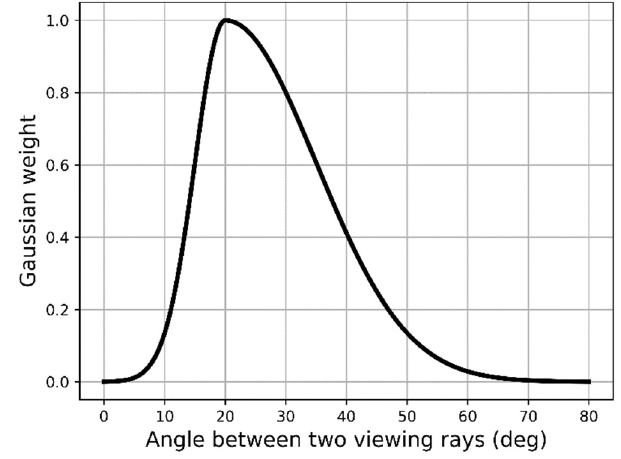
Figure 1. Gaussian weight to the angle (adopted from Furukawa et al. [34]). The final accuracy of 𝑃 is taken as the minimum value of 𝜎 (cid:3014)(cid:3023)(cid:3020) (cid:4666)𝑃, 𝐼 (cid:3039) , 𝐼 (cid:3040) (cid:4667) in every image pair combination. More details can be found in Furukawa et al. [34].